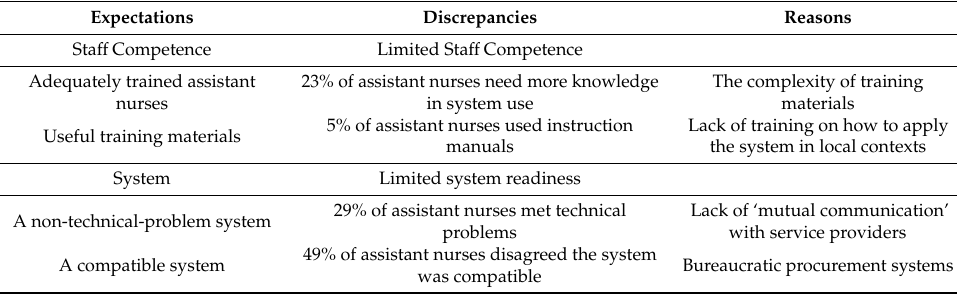
Table 4. Identified discrepancies between expected and actual implementation, and corresponding